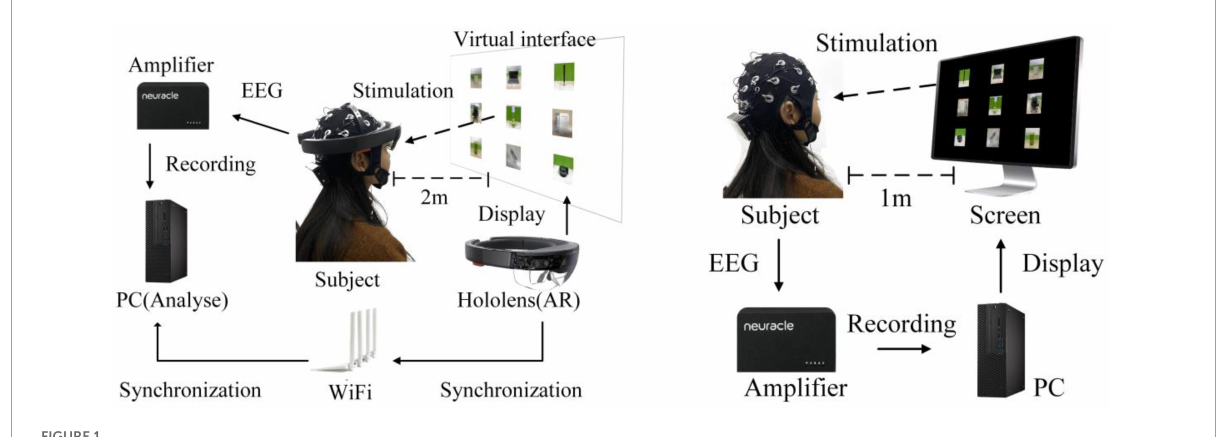
FIGURE1 Experimental environment in panels (A) AR–P300 and (B) CS–P300.